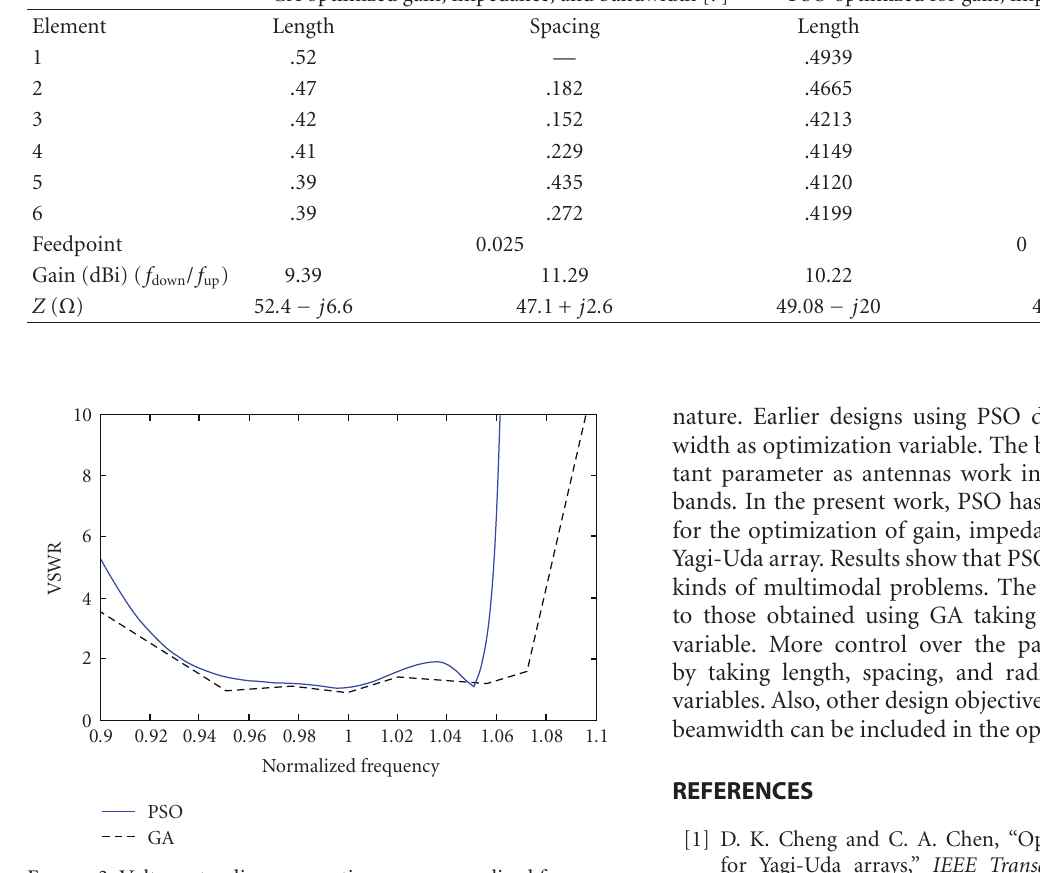
Figure 3: Voltage standing wave ratio versus normalized frequency for GA and PSO.